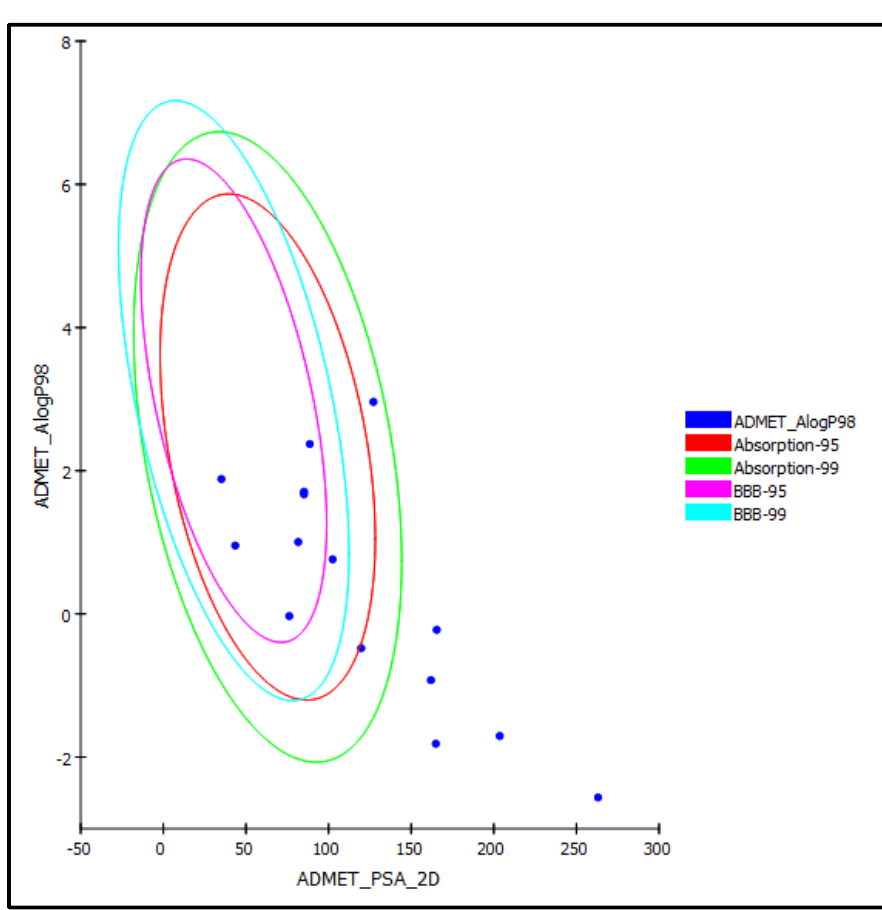
Figure 6. ADMET plot for of phenolic bioactive compounds previously identified from Matricaria chamomilla flowers, showing 95% and 99% confidence limit ellipses, corresponding to the blood-brain barrier (BBB) and human intestinal absorption models in ADMET_AlogP98. Similarly, together with co-crystalized ligand (NFT) and quercetin, they showed undefined penetration via BBB with level 4 and, hence, were placed outside the 99% BBB